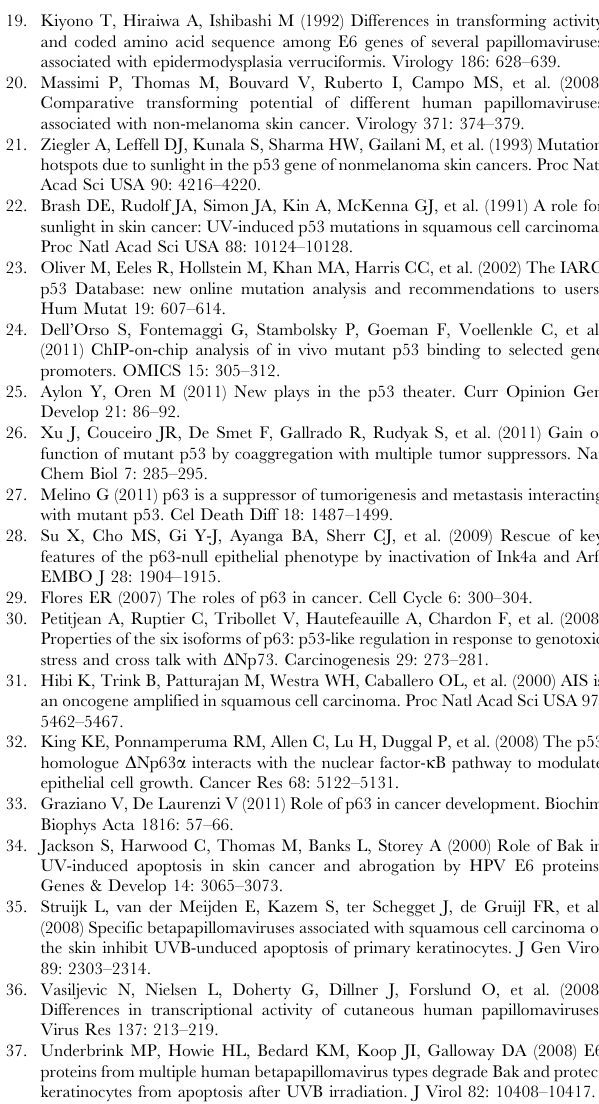
pLXSN-NIKS cells by Western blot analyses. Histograms indicate levels adjusted against b -actin which served as loading control. (TIF) Table S1 Primers for plasmid design. Primers used for PCR amplification of N-terminal or C-terminal flag-tagged E6 and C-terminal hemagglutinin (HA)-tagged E6. Full-length genomes were used as template for the E6 amplification of HPV types 4, 5, 7, 20, 27, 38, 41, 48, 60 and